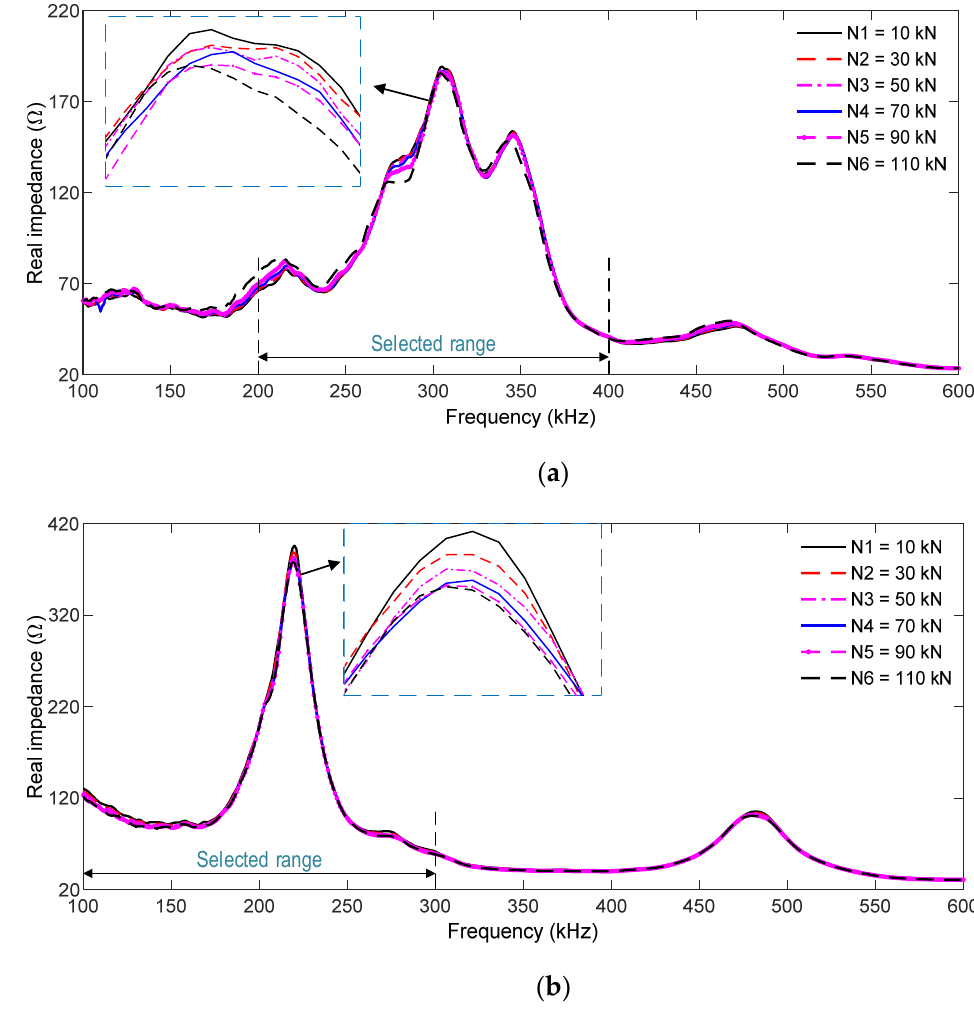
Figure 13. Experimental impedance responses of PZT sensors in the concrete sample under compression: ( a ) PZT-embedded smart rebar (SR); ( b ) PZT-embedded smart aggregate (SA).